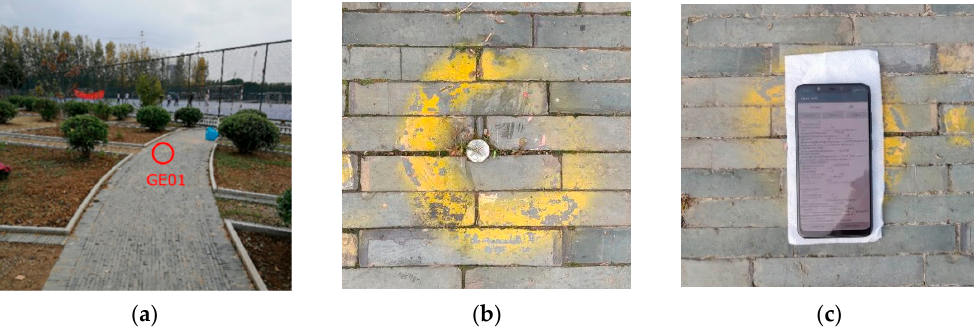
Figure 2. The control point named GE01 at Southeast University Jiulonghu Campus. The precise coordinates of this control point are obtained by a geodesic receiver through the network RTK positioning method. ( a ) Distant view of the control point; ( b ) Close-up of the control point; ( c ) A Xiaomi MI 8 smartphone placed on the control point.